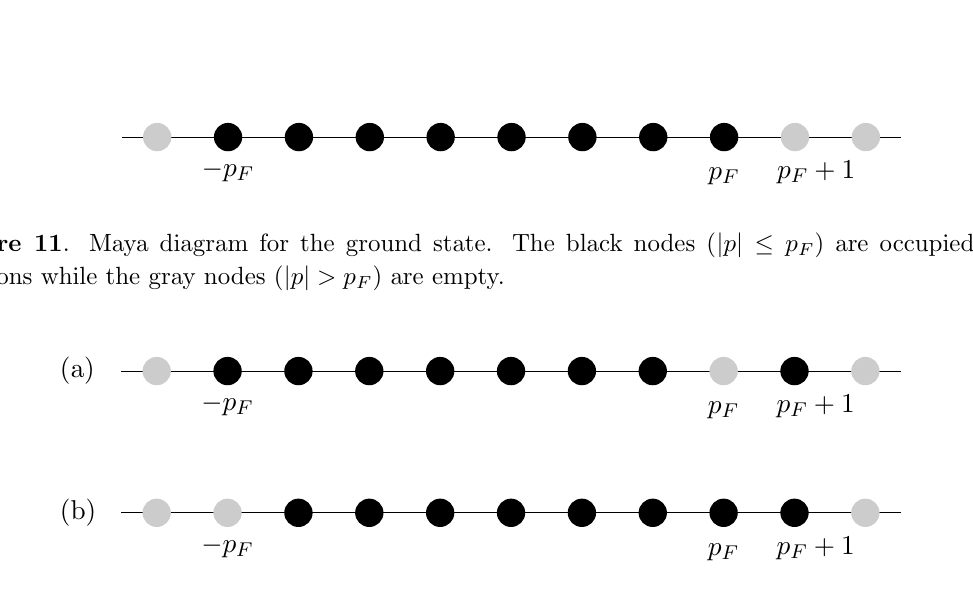
Figure 12 . Examples of excited states: (a) chiral excitation (b) non-chiral